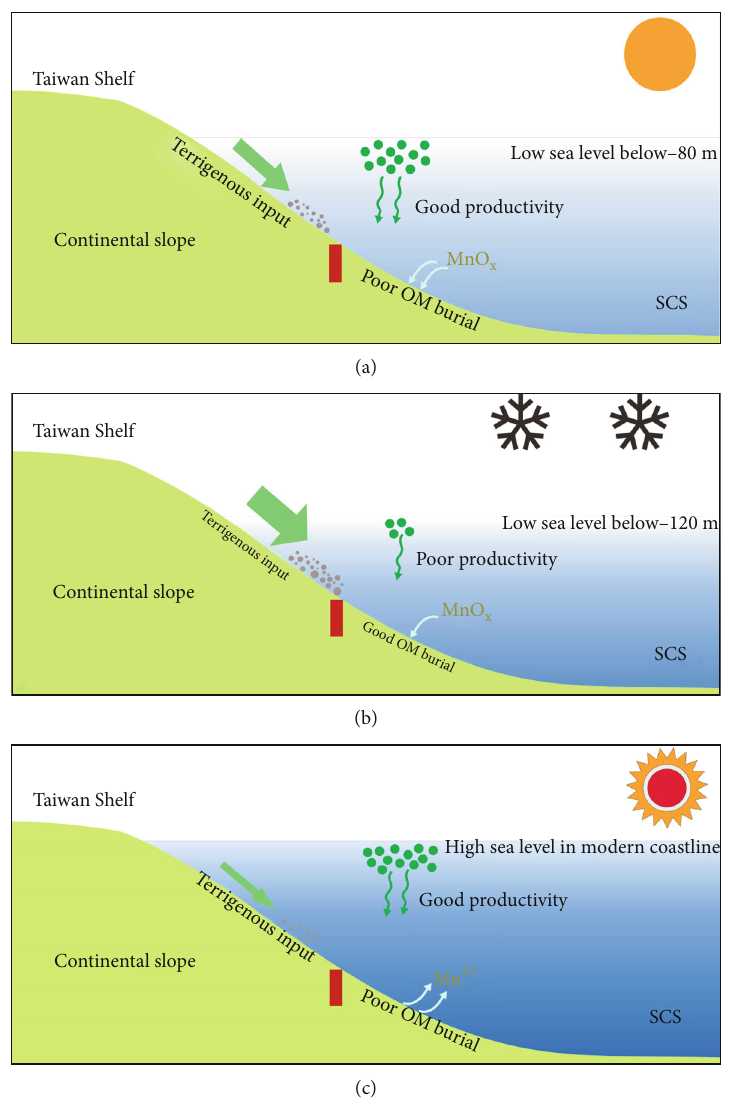
Figure 9: Schematic cartoons showing the terrigenous input, organic carbon burial, redox condition in the water-sediment interface, and ocean productivity at core 973-4 located in the northeastern SCS at the (a) interstadial phase during the last glaciation with low sea level (stage I), (b) period of glaciation with the lowest sea level (stage II), and (c) Holocene in sea-level highstand with warm and humid climate (stage IV), with the exception of the stage III in fl uenced by the turbidity current. The size of shallow green arrows indicates the fl ux of terrigenous input. Core 973-4 is labeled as a red pillar. The ocean productivity in the surface water is expressed by bottle green circles, and higher productivity as indicated by more circles represents the enhanced biogenic CaCO input to deep sea and the sea fl oor. Dashed area 3 with color from blue to white represents dissolved O content from low to high in the ocean documented by the phase of 2